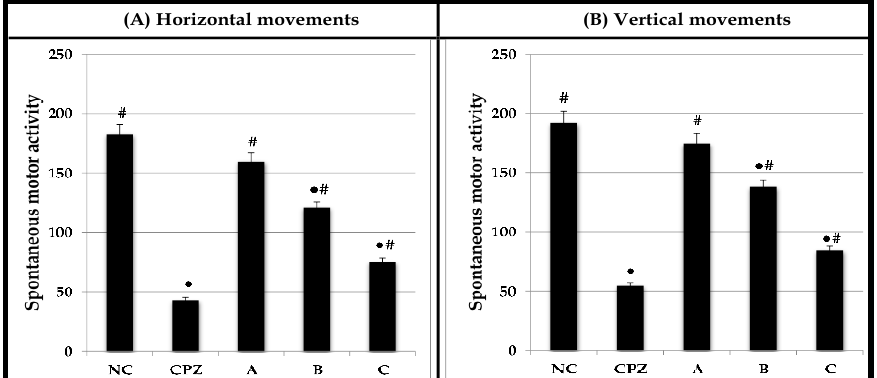
Figure 3. Effect of CPZ and A, B, and C formulae on spontaneous motor activity of rats for 10 min using activity cage. Values are expressed as mean ± SEM, n = 6 rats/ group. ● Significant change at p ≤ 0.05 with respect to negative control (NC) rats. # Significant change at p ≤ 0.05 with respect to CPZ-treated rats.